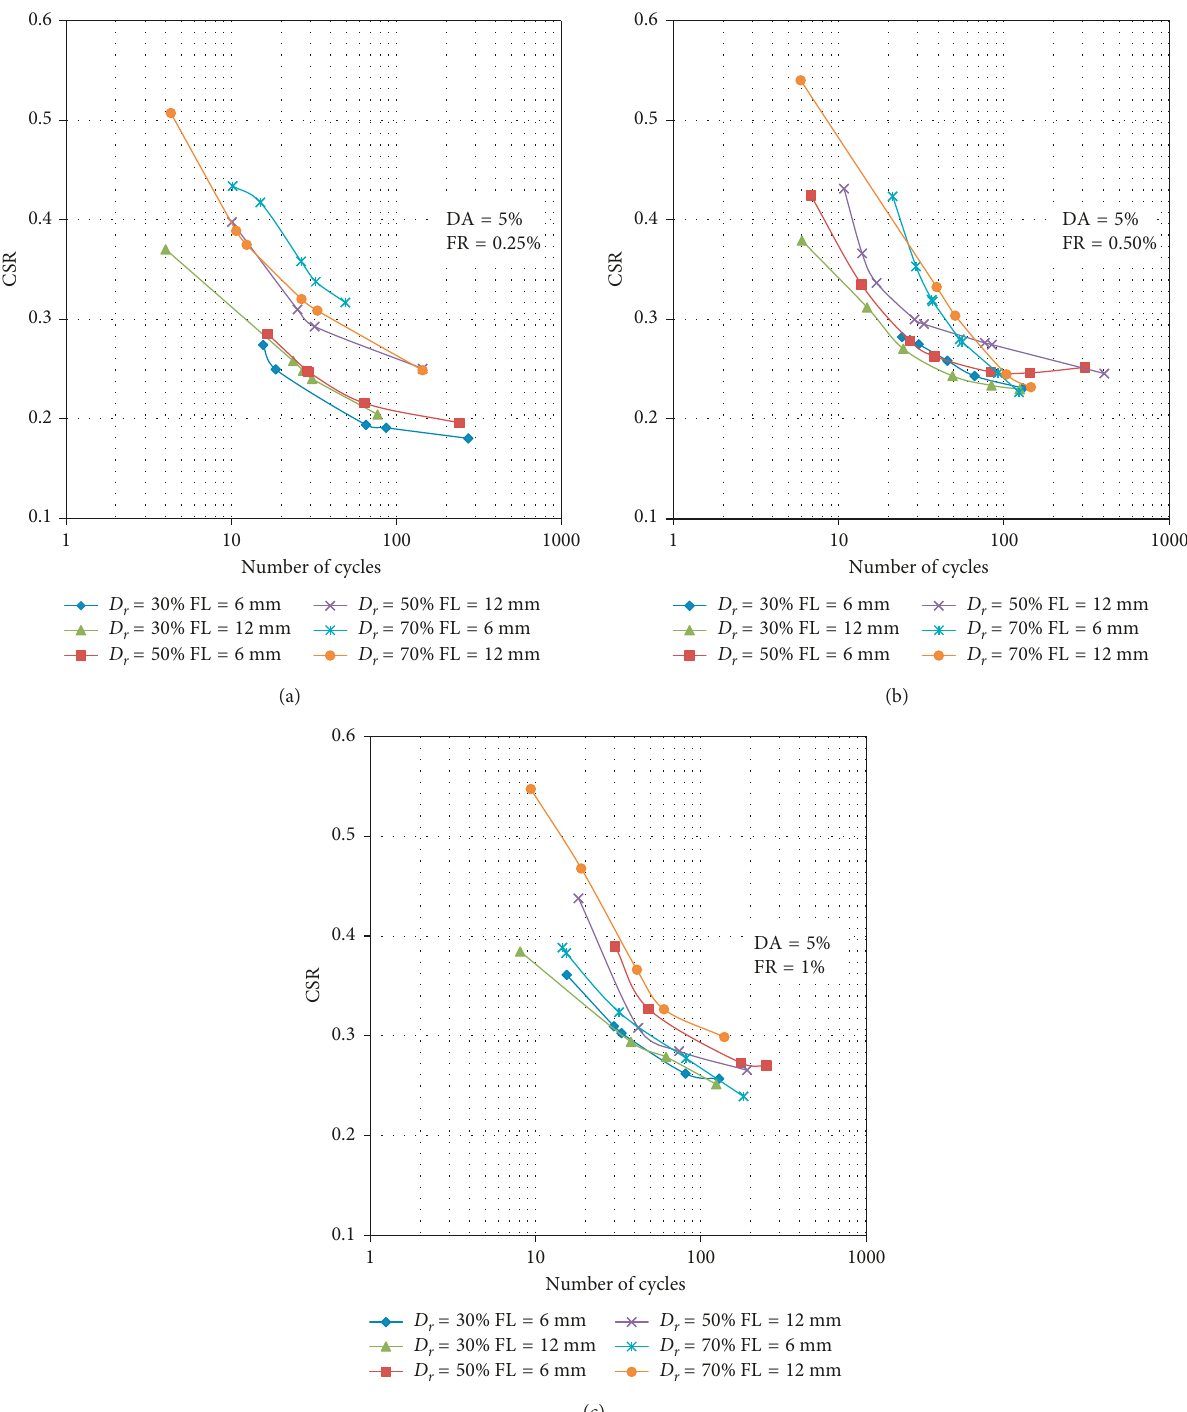
Figure 7: Variation of CSR with the number of cycles considering the effect of fiber ratio (a) FR (